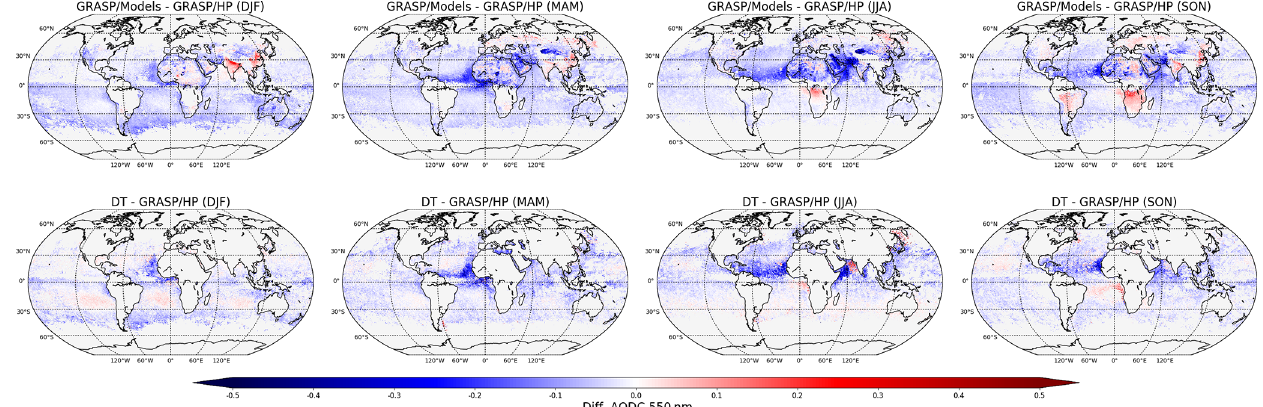
Figure 27. The same as Fig. 25, but for AODC (550nm).